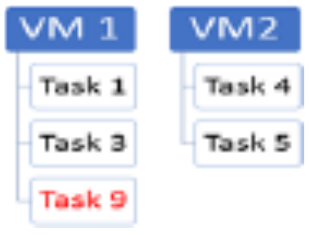
Fig. 4. Tasking mapping on